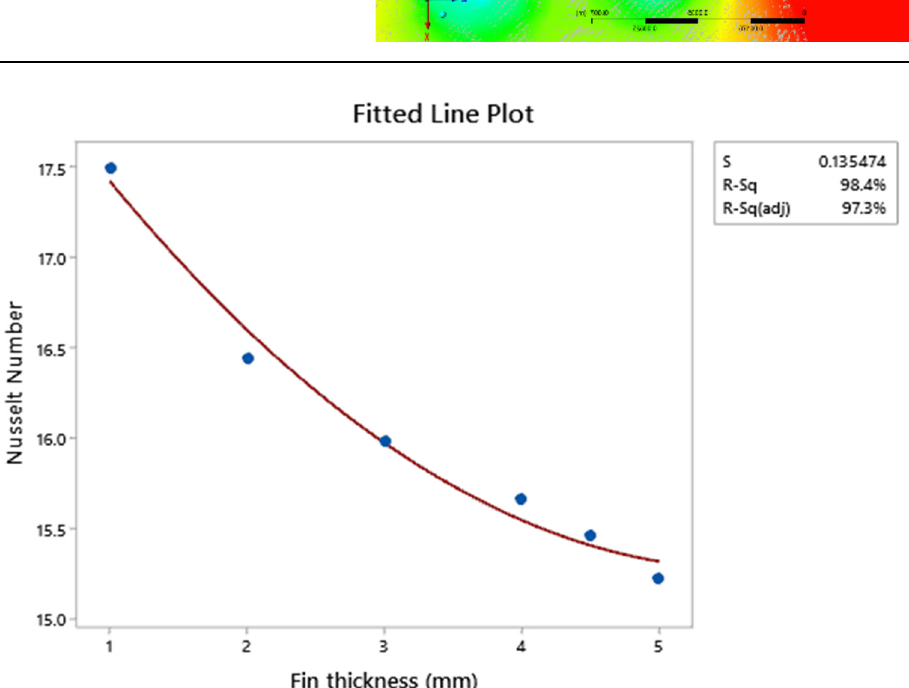
Figure 17. Fitted line plot for Nusselt number vs fin thickness.